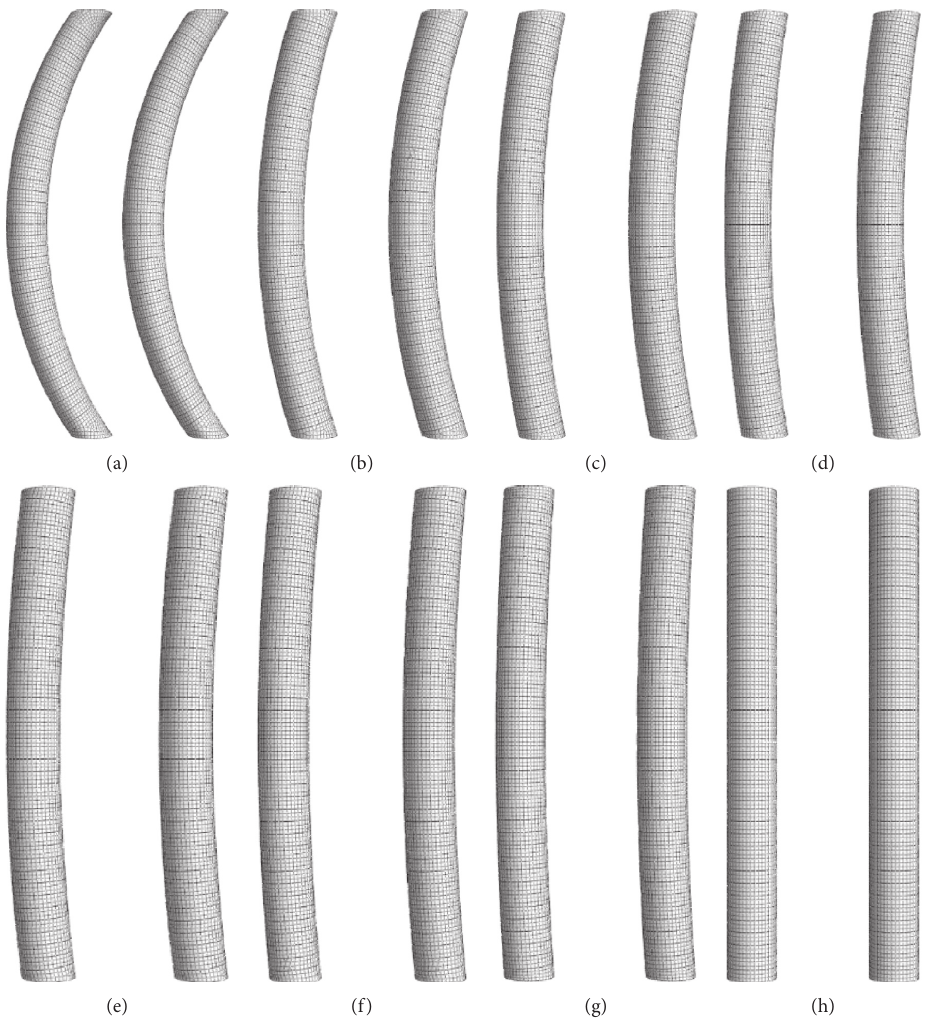
Figure 5: Meshing of the curved shield twin tunnels with a radius of curvature of: (a) 50m, (b) 100m, (c) 150m, (d) 200m, (e) 250m, (f) 300m, (g) 400 m, and (h)